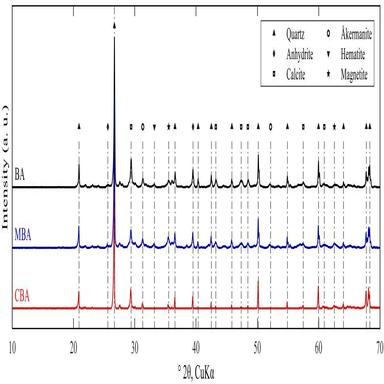
XRD patterns of the as-received BA, MBA, and CBA.